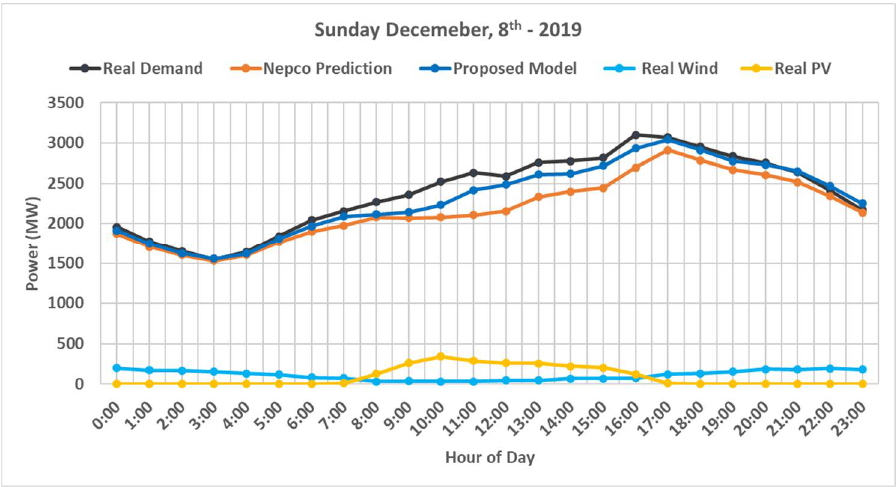
Figure 17. Selected case study day in December 2019.